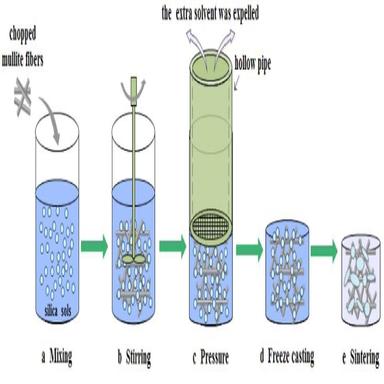
The processing route schematic of PFMs by pressure and freeze casting. (For interpretation of the references to color in this figure legend, the reader is referred to the web version of this article).